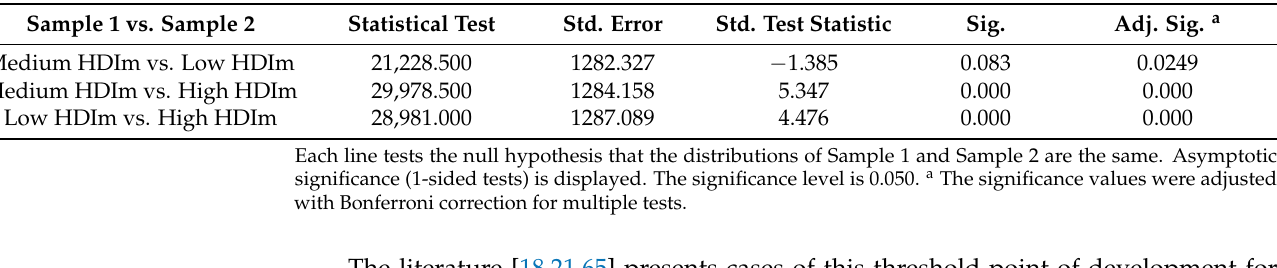
Table 8. Pairwise comparisons of